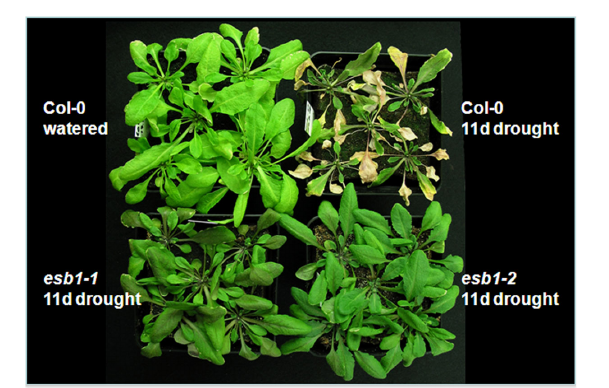
FIGURE 3 | Drought tolerance in the enhanced suberin 1 (esb1) mutant. Arabidopsis wild-type plants and two allelic esb1 mutants were cultured in soil for 3weeks with regular irrigation. Subsequently watering was discontinued. Plants were recorded 11days after water withdrawal. A wild-type without water withdrawal served as a control (Upper